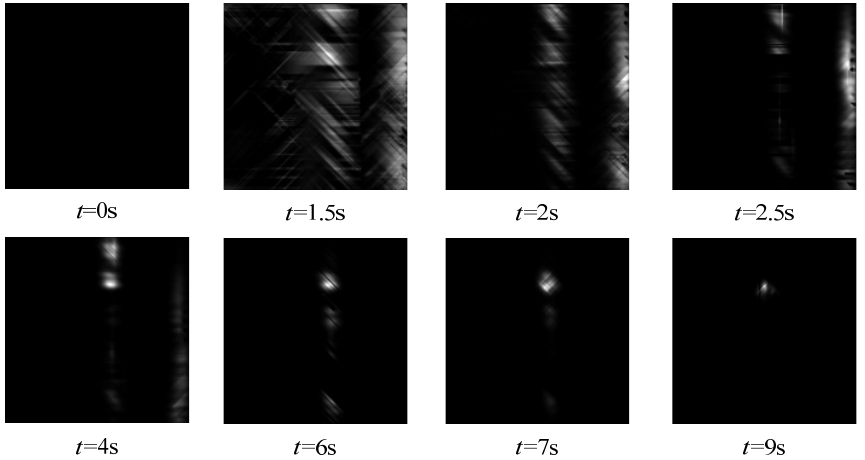
Figure 12. Probability distribution in constraint window scale during the WCML process. Brighter color shows higher probability. The distribution is changed from a decentralized state to a centralized state. The centralized state in t = 9 s shows that the vehicle finally finds its